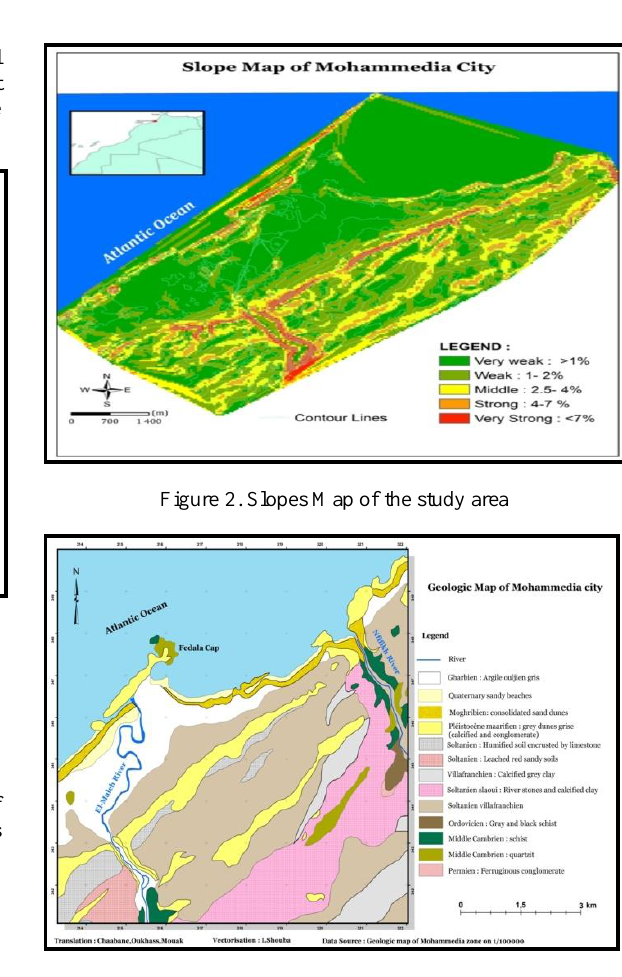
Figure 3. Geological Composition of the Study